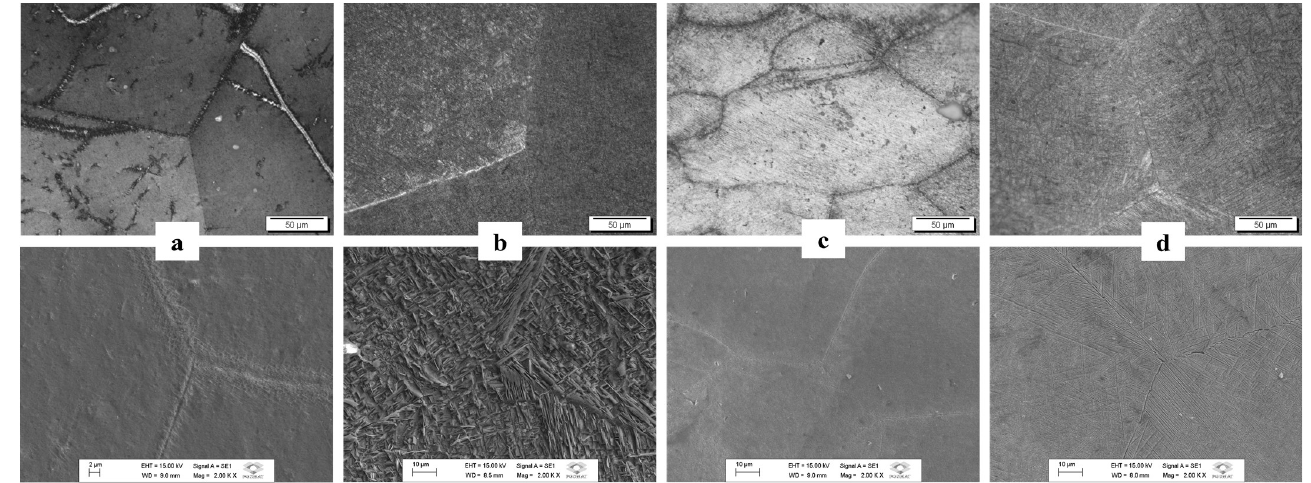
Figure 4. Optical micrographs (above) and SEM micrographs (below) in as-cast ( a ), homogenized